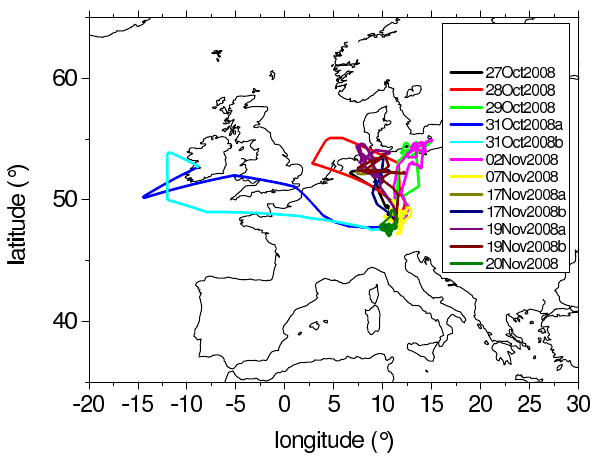
Fig. 3. Trajectories of 12 mission flights performed during the CONCERT (CONtrail and Cirrus ExpeRimenT) campaign in Oc- tober/November 2008 over Western Europe. The flight dates are given in the legend.